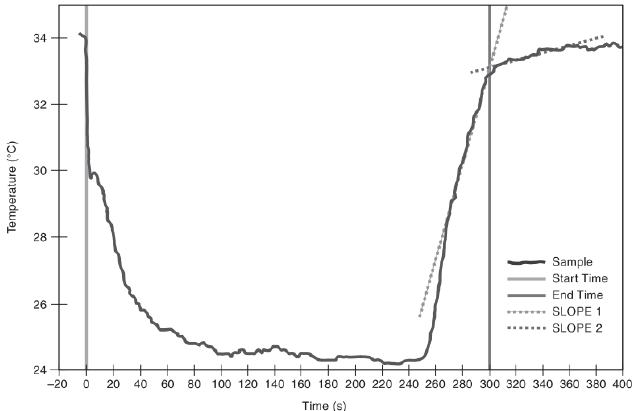
Figure 8. Temperature vs. Time curve to determine drying time [36] .